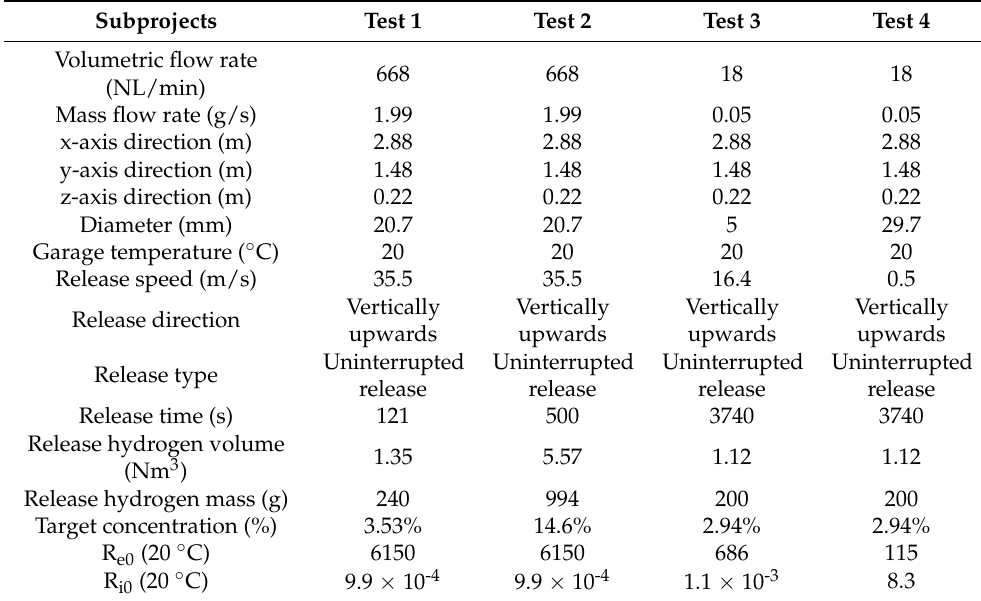
Table 2. Effects of the different injection conditions on the hydrogen